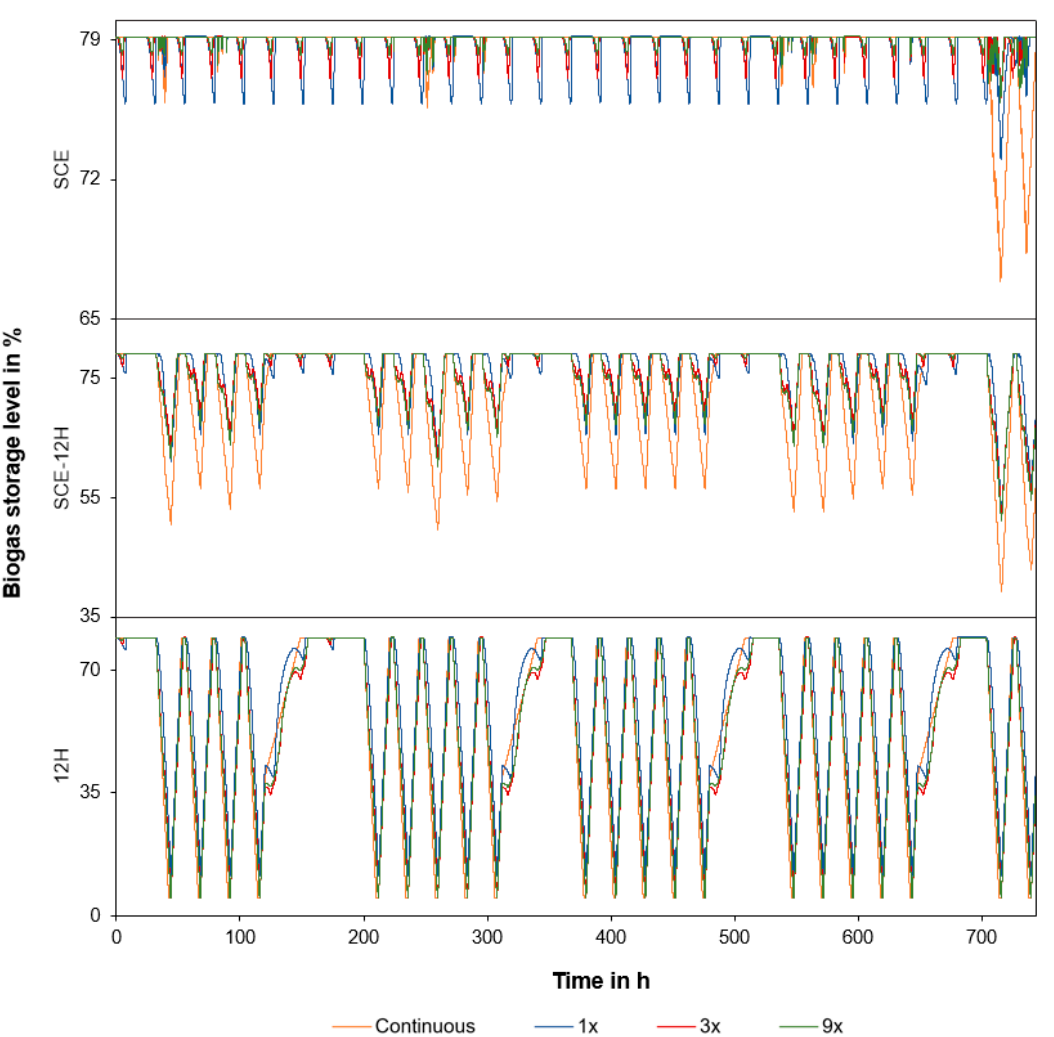
Figure 8. Comparison of the three investigated feeding strategies to continuous feeding of feedstock in terms of simulated biogas storage level for OLRs of 2.15 kg vs. m − 3 d − 1 .